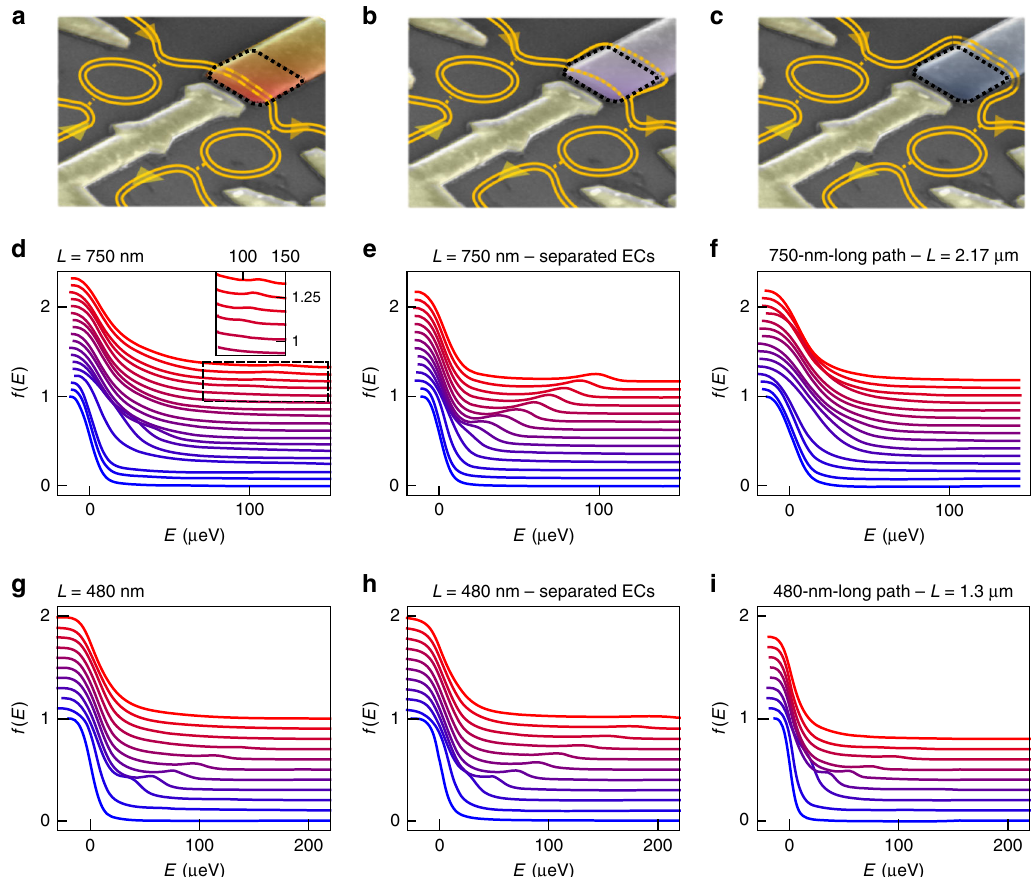
Fig. 5 Effect of the length gate on energy relaxation. a – c False-color scanning electron micrographs of a typical sample, depicting the trajectories of the ECs for V L = 0.2 V ( a , length gate highlighted in red), V L = − 0.1 V ( b , gate highlighted in violet), and V L = − 0.5 V ( c , gate highlighted in dark blue). In a , the ECs copropagate along the short path. In b , the ECs are spatially separated (orange dotted lines) as they fl ow below the length gate. In c , the ECs copropagate along the long path. d – f Measured f ( E ) in the 750 nm device for the con fi gurations depicted in respectively, a , b , and c . Each curve, offset for clarity, corresponds to an injection energy increment δ E 1 ≈ 9 μ eV, from E 1 ≈ − 26 μ eV (blue) to E 1 ≈ 122 μ eV (red, d )/ E 1 ≈ 98 μ eV (red, e , f ). The inset in d is a zoom on the region delimited by the black dotted square. g – i Measured f ( E ) for the con fi gurations in the 480 nm device depicted in respectively, a , b , and c . Each curve, offset for clarity, corresponds to an injection energy increment δ E 1 ≈ 21 μ